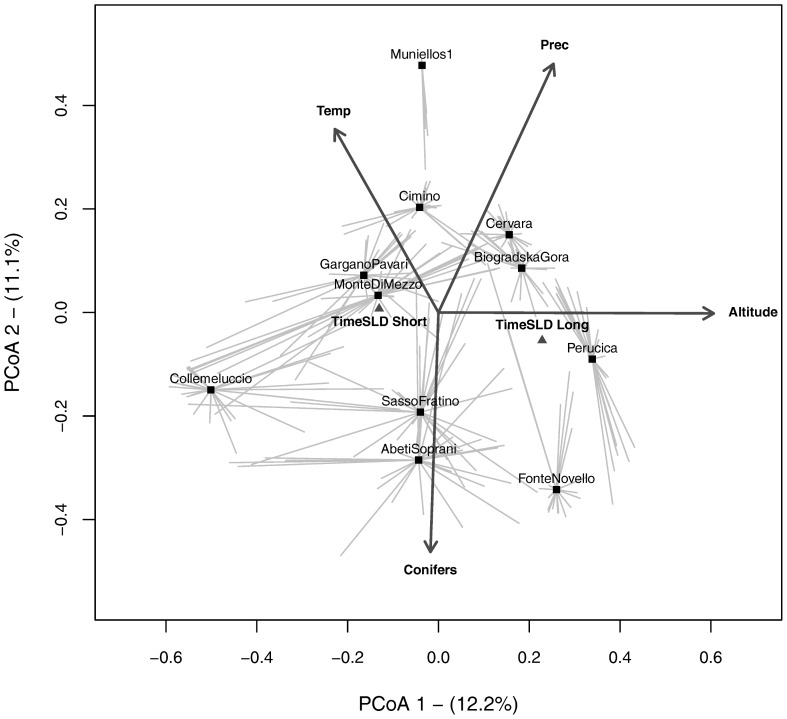
Understorey multivariate dispersion from stand centroids.Multivariate dispersion of quadrats (tips of gray lines) from stand centroids (black squares) in the multivariate space defined by the first two axes of a PCoA calculated on ground layer species composition in 11 old-growth beech forests of southern Europe. Site environmental variables were passively projected on the ordination to help the interpretation of the PCoA axes, either as vectors (quantitative variables) or black triangles (nominal variables). Temp: Average annual mean temperature; Prec: Average annual precipitation; Time SLD  =  Time Since Last Disturbance (Long >100 yrs, Short  =  <100 yrs).